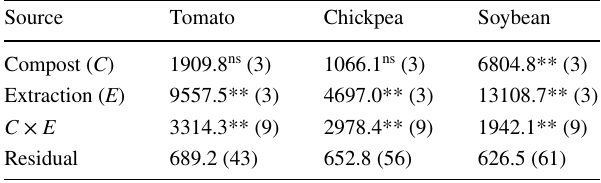
Table 3 Mean sum of squares for GI of composts obtained from straws of sorghum, finger millet, soybean and sorghum straw + saw dust (values inside parenthesis indicate degrees of freedom)